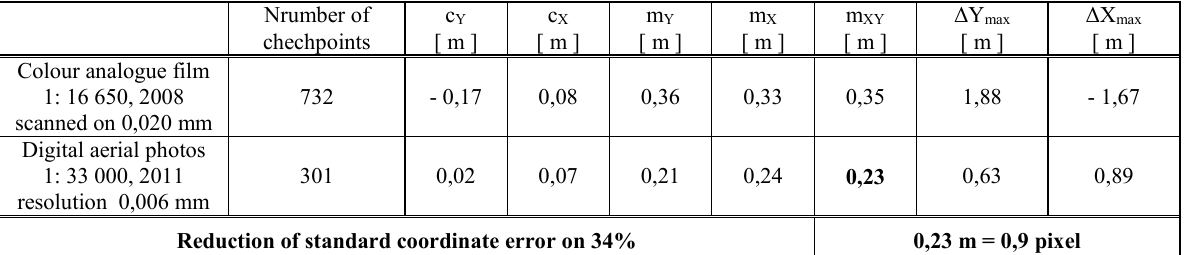
Table 1. Reduction of standard coordinate error (Plzeň test locality in 2008 and 2011) Locality